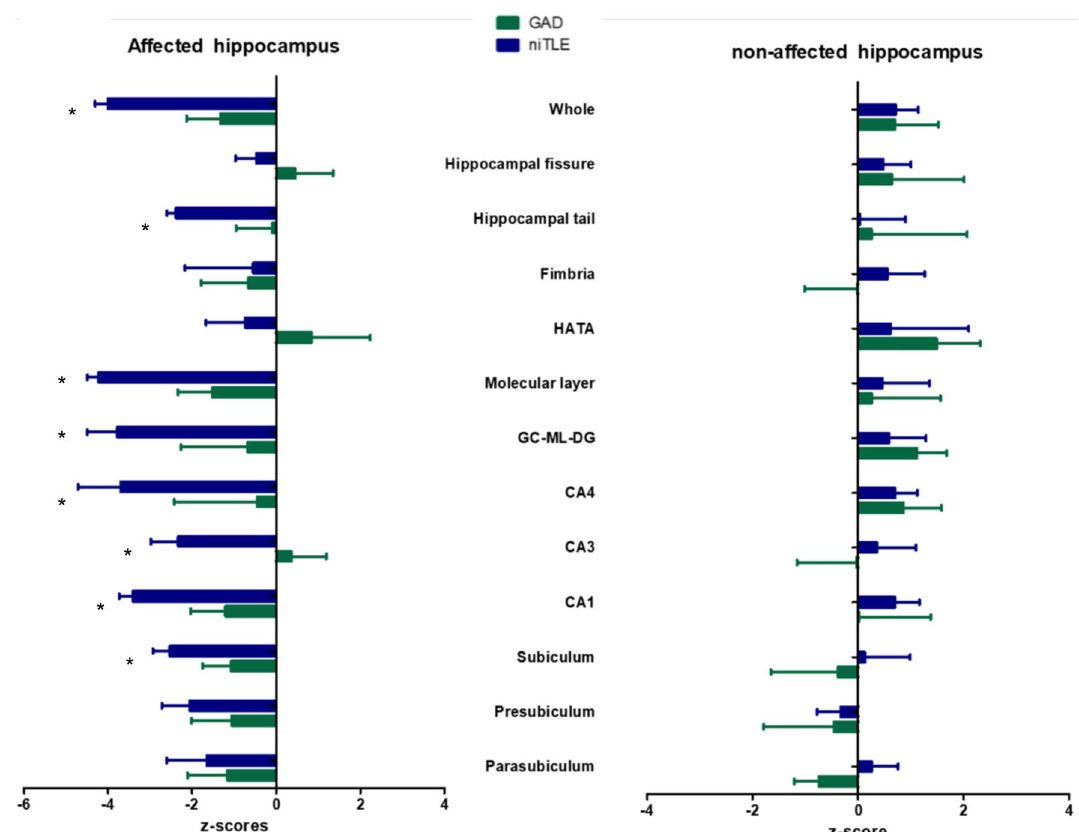
Figure 1. Z-scores of hippocampal subfields volume deviation from HC of each subfield in the affected and contralateral hippocampus of GAD-TLE and niTLE (Median;